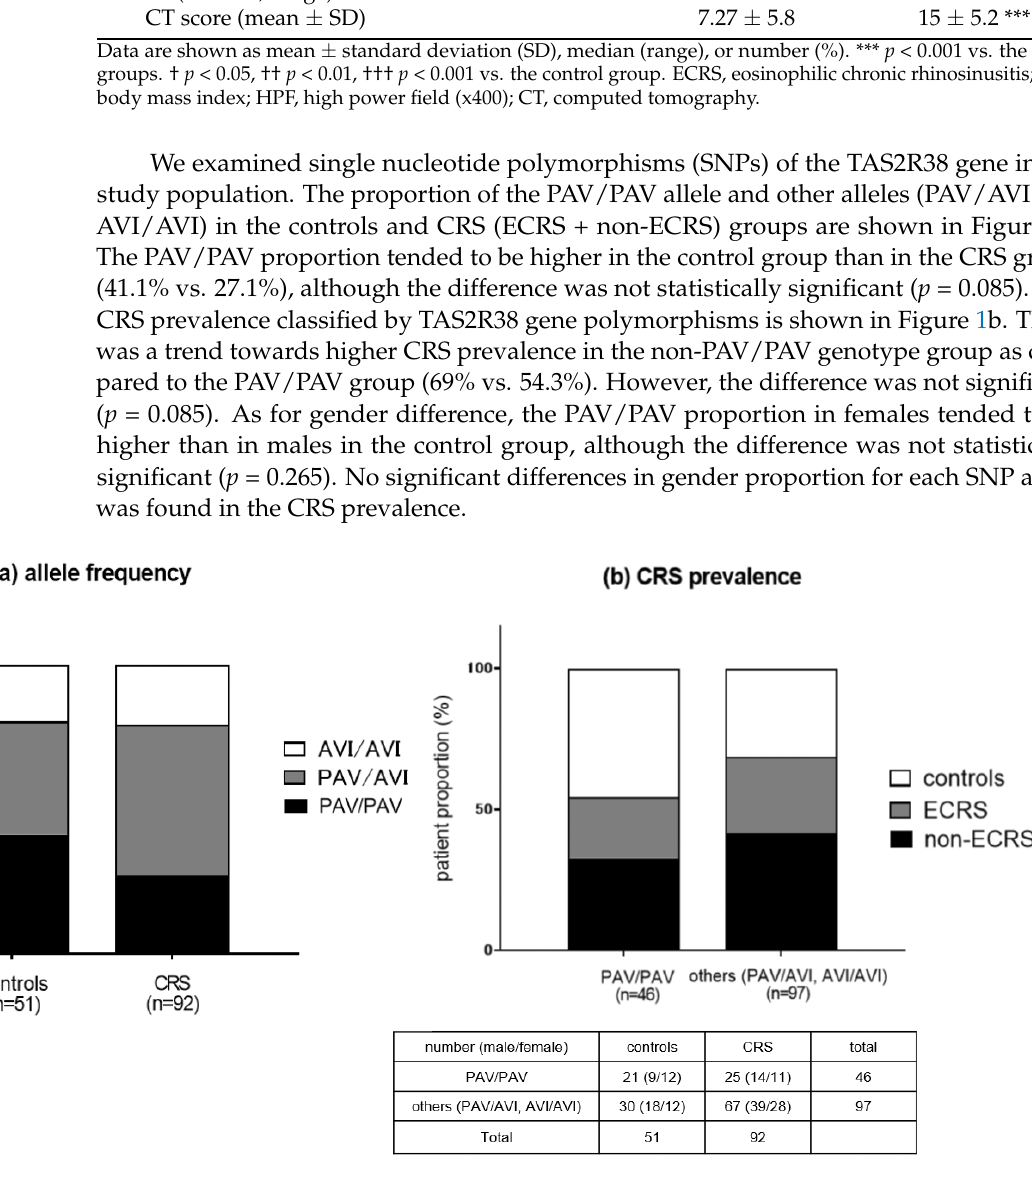
Table 1. Background and baseline characteristics of the study population.